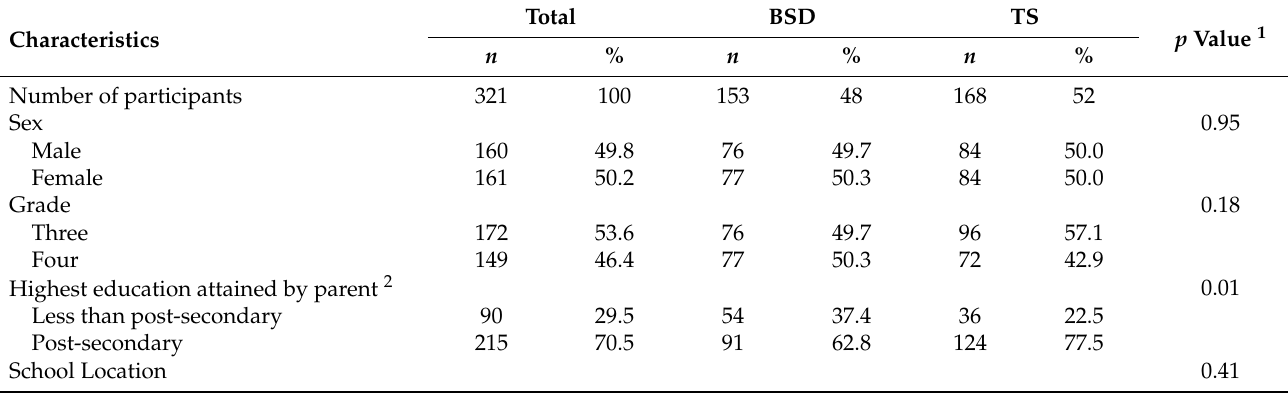
Table 1. Participant characteristics by school